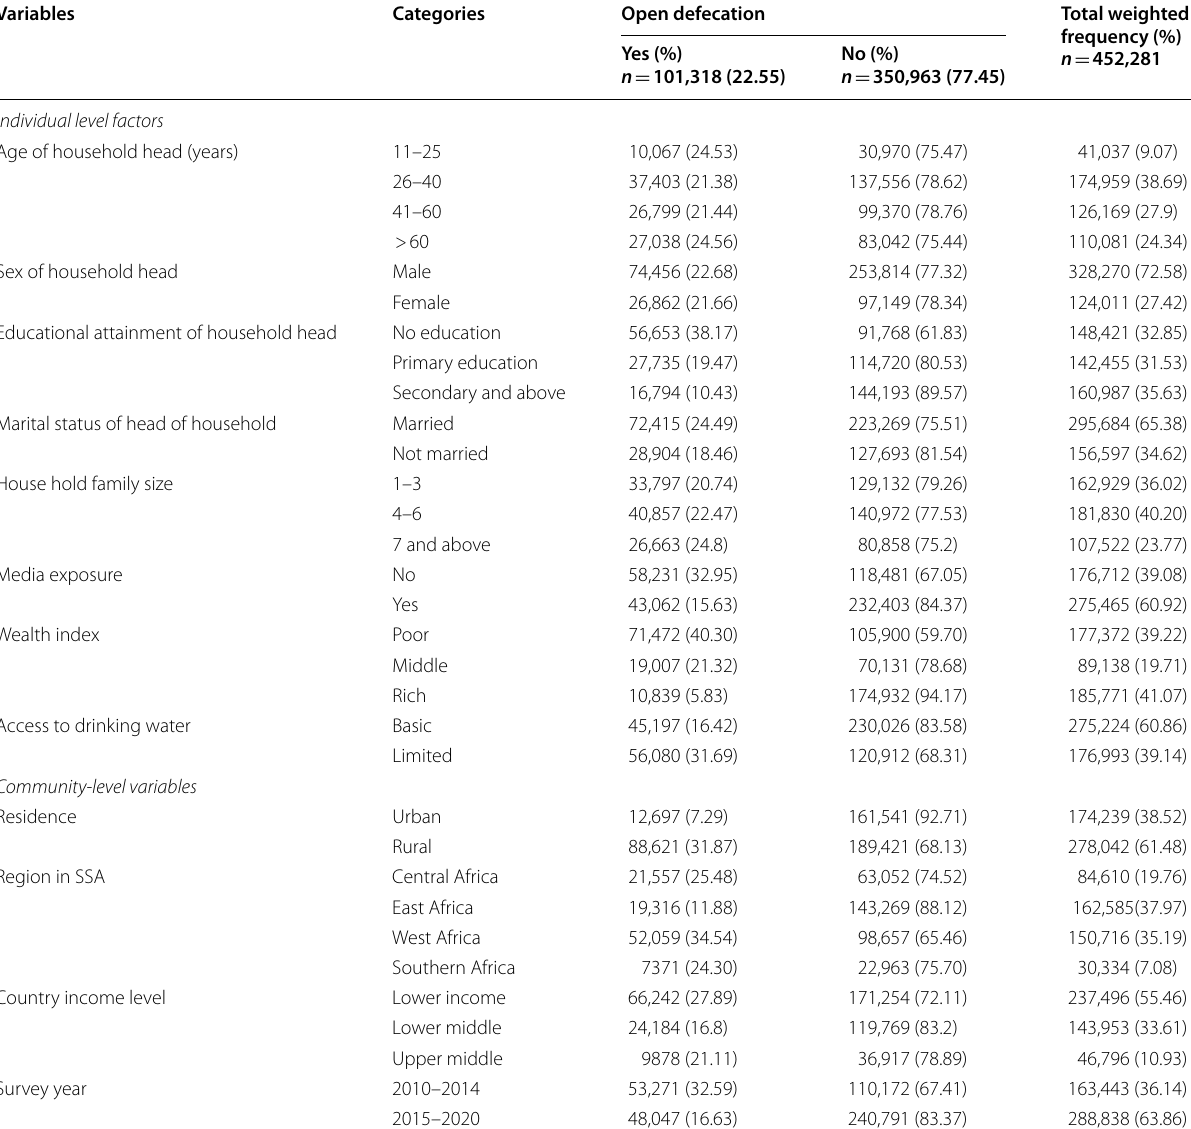
Table 3 Socio-demographic characteristics of the study households with open defecation and determinants among households